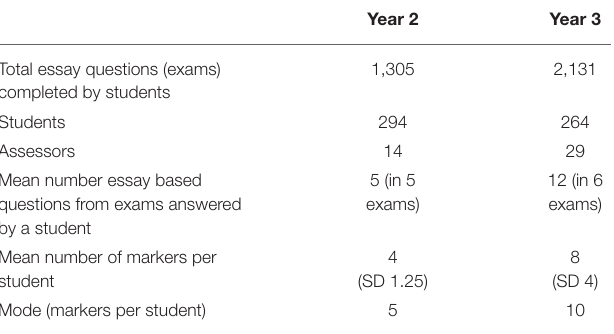
TABLE 4 | Essay based questions, exams, students and